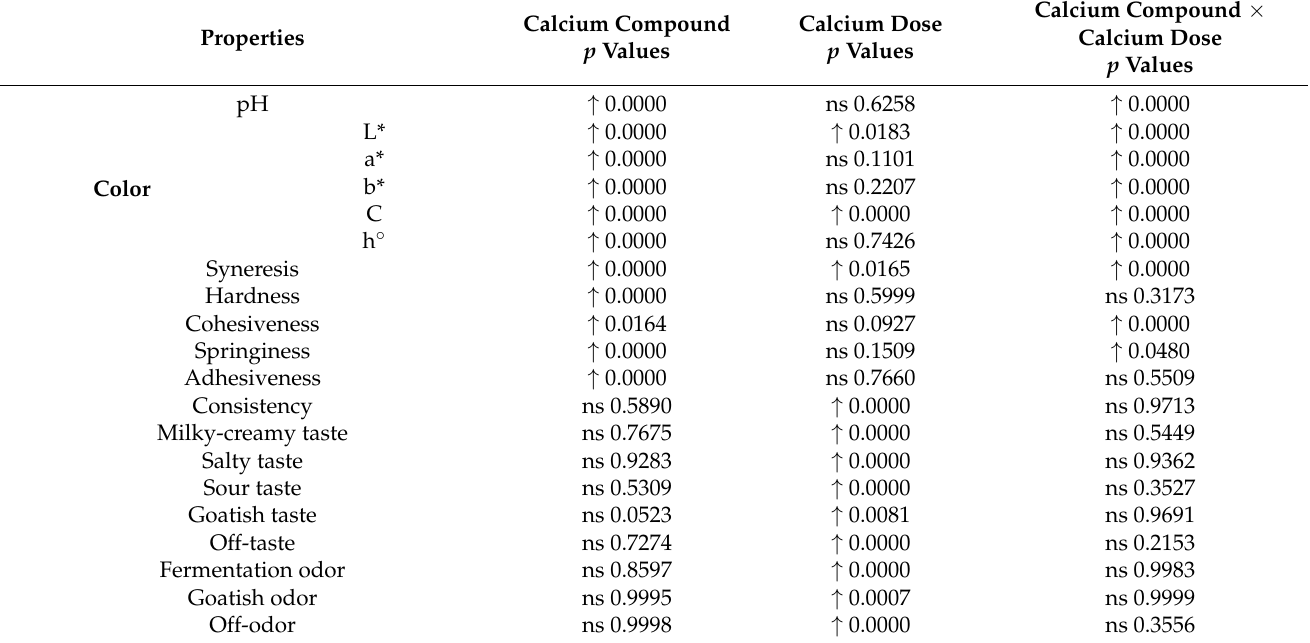
Mean ± standard deviation; a–d Means with different letters in rows indicate statistically significant differences at p < 0.05; 9 samples × 30 batches = 270 acid rennet goat milk gels samples. The addition of calcium chloride and gluconate to goat’s milk at increasing doses resulted in a significant decrease in the gel’s pH value ( p ≤ 0.05) compared to the control sample. An opposite correlation was found in goat gel with citrate, bisglycinate, and carbonate. The increasing dose of calcium resulted in the formation of acid and rennet gel with a significantly higher pH value ( p ≤ 0.05) than in the control sample. The performed analysis of variance ANOVA (Table 4) indicated that the pH value of the milk gels was significantly affected by the calcium compound and the interaction of calcium compound and calcium dose. Table 4. Analysis of variance (ANOVA) p values on the effects of calcium compound and calcium dose on pH, color parameters: L*, a*, b*, C, h ◦ , syneresis, hardness, cohesiveness, springiness, adhesiveness, consistency, milky-creamy taste, salty taste, sour taste, goatish taste, off-taste, fermentation odor, goatish odor and off-odor of acid rennet goat’s milk